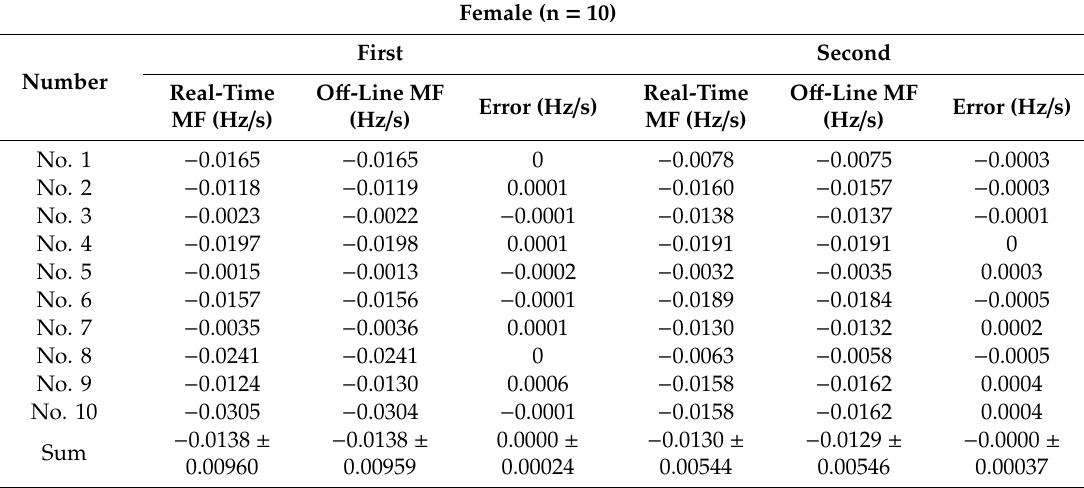
Table 4. All slope values of MF change for the ten female